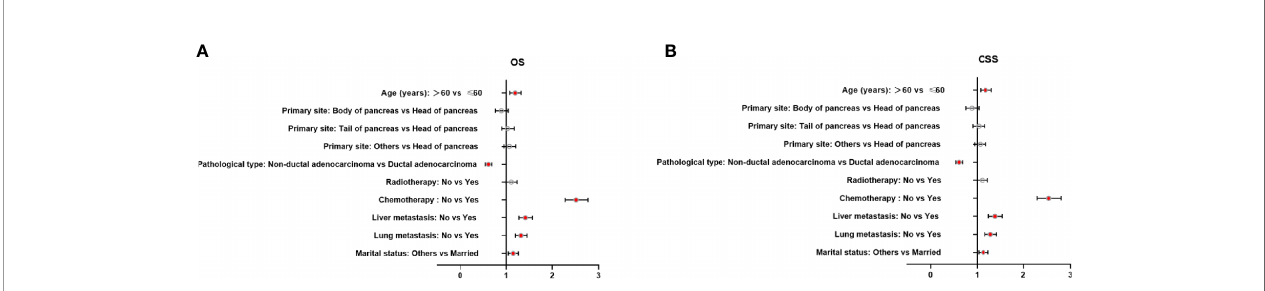
FIGURE 2 | Forest plots of the predictors of OS (A) and CSS (B) in patients with PCBM. (PCBM, pancreatic cancer bone metastasis; OS, overall survival; CSS, cancer-speci fi c